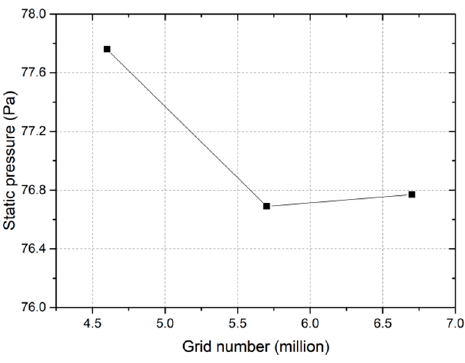
Figure 3. Variation of static pressure rise with grid number of impeller domain.